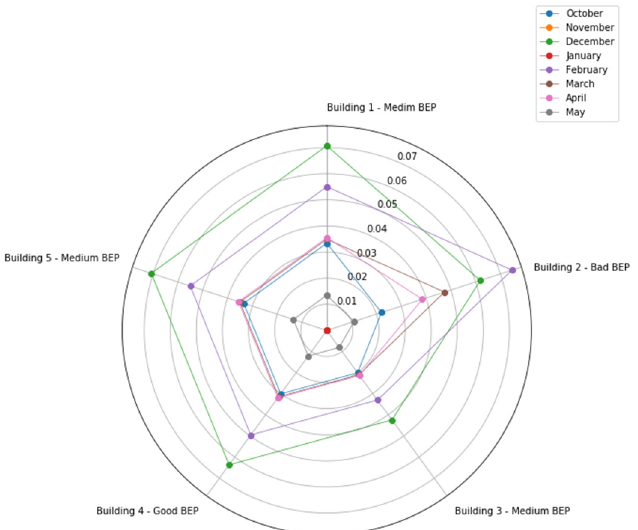
Figure 13. Daily energy savings obtained with 50% decrease from average consumption without DR repetitions per building—months with more consistent average temperature over the analysed pe-